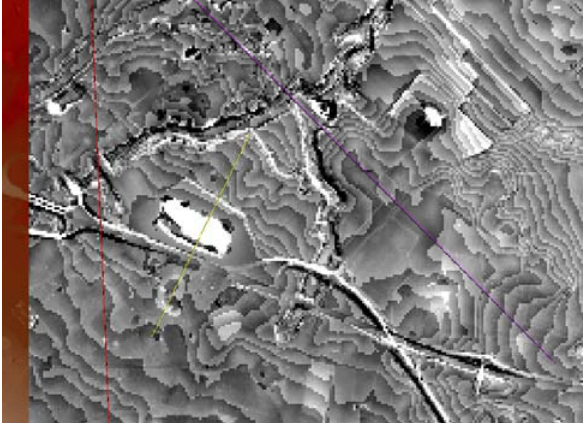
Figure 16. Differences between two DEMs (test